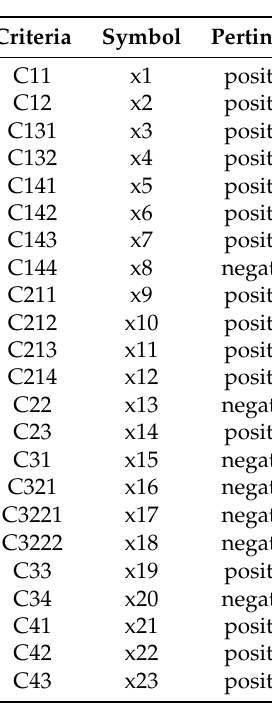
Table 3. The feature of 5